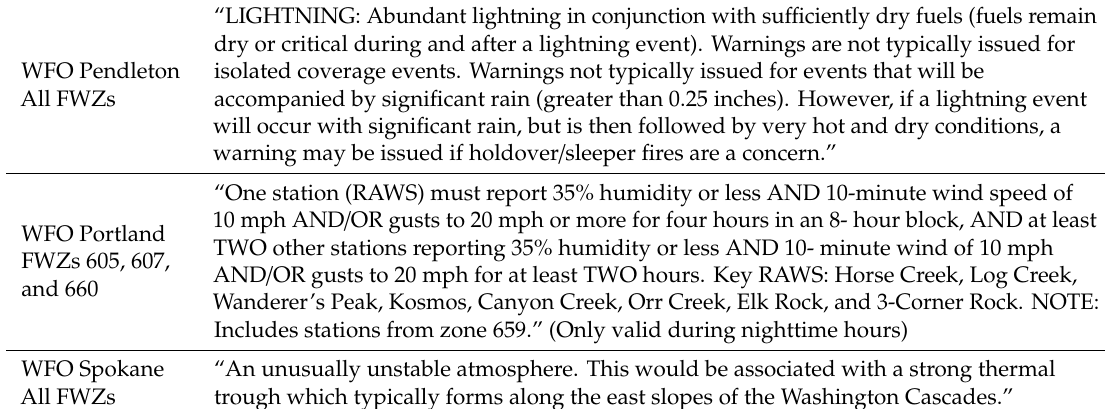
Table 1. Select criteria for issuing Red Flag Warnings (RFWs) at di ff erent weather forecast o ffi ces (WFOs) taken from the 2019 Northwest Area Fire Weather Annual Operating Plan available at https: // gacc.nifc.gov / nwcc / content / pdfs /